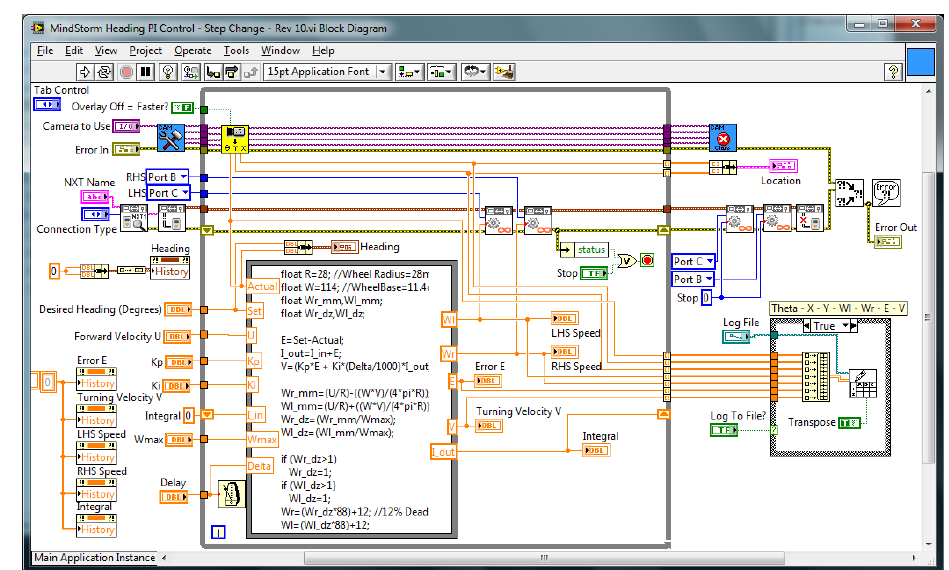
Figure 19. PI Controller LabVIEW Implementation – Heading Control